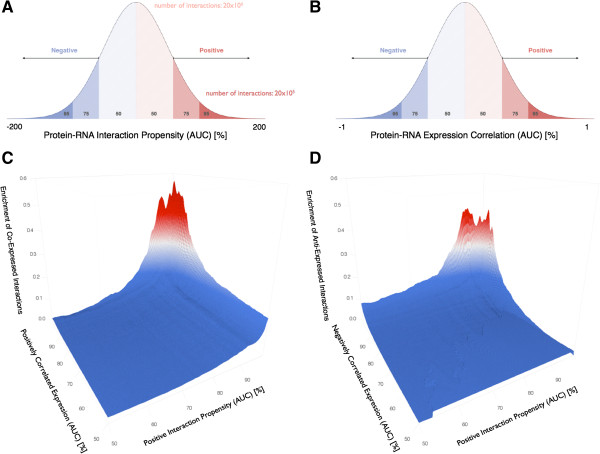
Protein–RNA interaction and expression. (A) In this analysis, we compared interacting and non-interacting protein–RNA pairs at different interaction propensity scores. Areas under the curve (AUCs), expressed as percentages, were used to select the same number of interacting and non-interacting protein–RNA pairs. (B) The same procedure was used to investigate positively and negatively correlated protein–RNA expression at different thresholds. (C) With respect to non-interacting protein–RNA pairs, the predicted associations had enriched positively correlated expression (that is, co-expression; see Materials and methods). (D) Compared to non-interacting protein–RNA pairs, the predicted associations had enriched negatively correlated expression (that is, anti-expression; see Materials and methods). Non-correlated protein–RNA expression did not show any similar trend (Additional file 1). AUC, area under the curve.